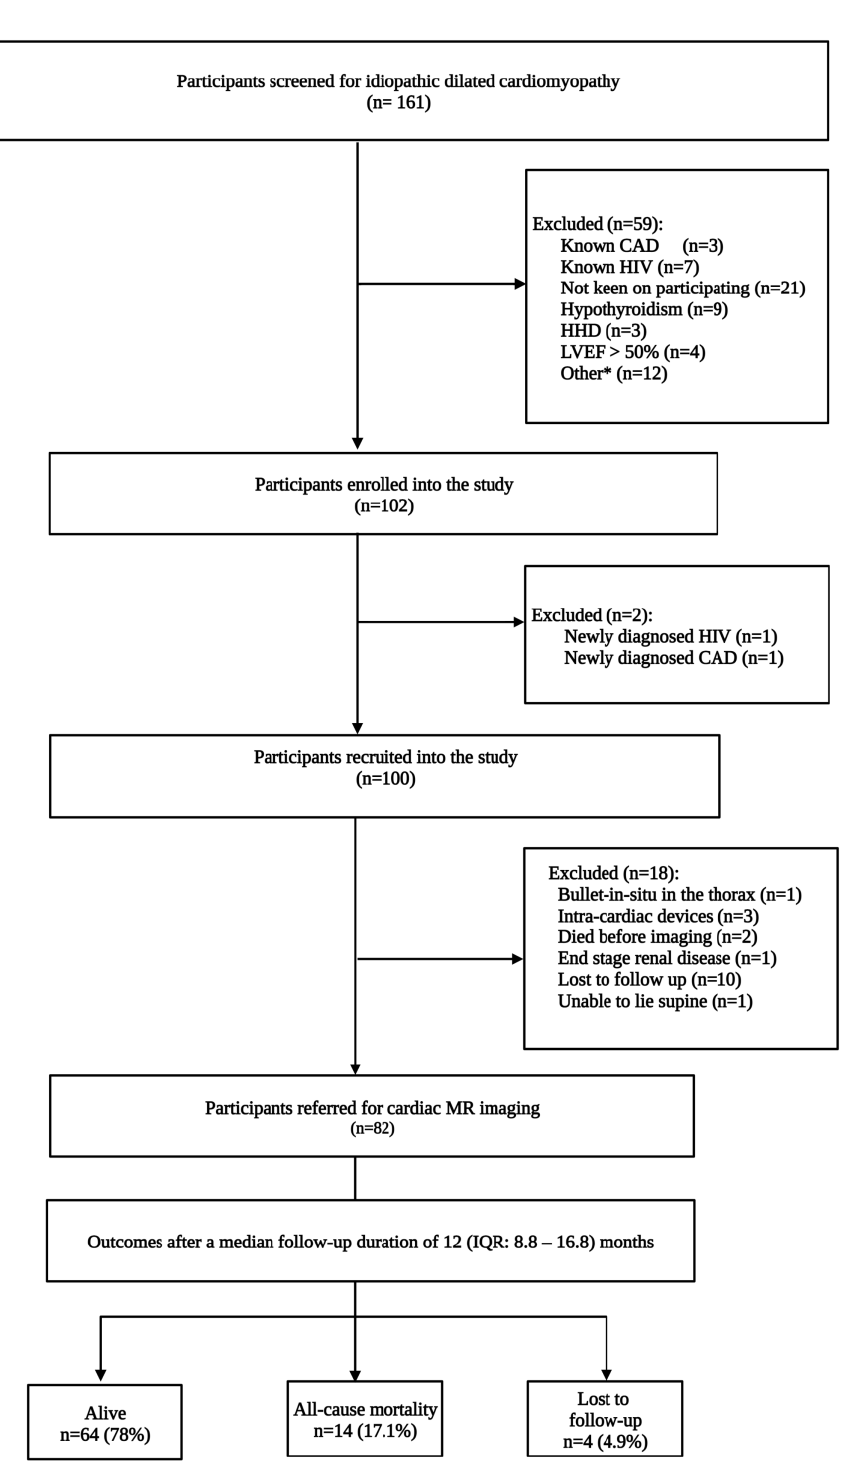
Figure 1. Flow chart detailing the identification of the study cohort. CAD = coronary artery disease, HHD = hypertensive heart disease, HIV = human immunodeficiency virus, LVEF = left ventricular ejection fraction. Other * refers to peripartum cardiomyopathy ( n = 1), malignancy ( n = 2), organic valvular heart diseases ( n = 2), pacemaker in situ ( n = 1), end-stage renal impairment ( n = 3), recreational substance abuse ( n = 1), unstable patient ( n = 1), dilated cardiomyopathy precipitated by supraventricular tachycardia ( n = 1) .